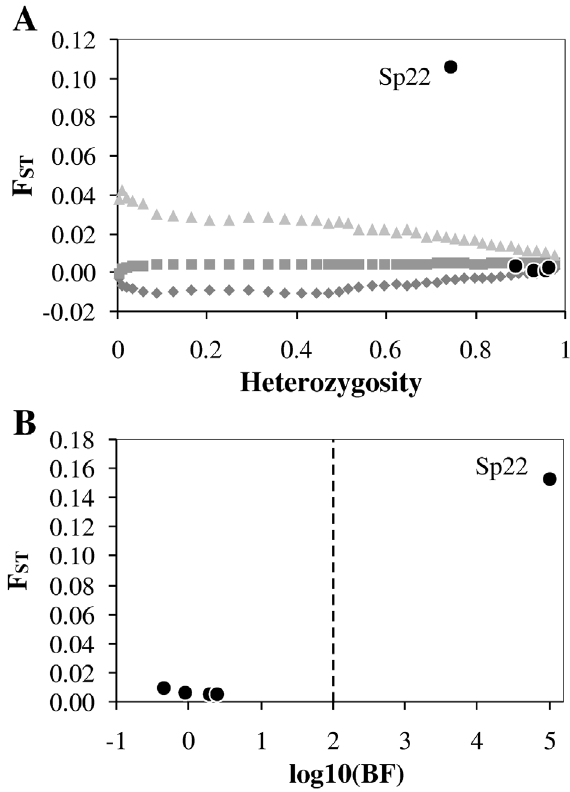
Fig . 3 – A, simulation results from the FDIST2 program. Upper and lower lines are the 95% confidence intervals and the middle line is the median. The estimated F and heterozygosity values for ST each locus (black circles) have been superimposed on the graph. B, results of the BAYESCAN approach. F values for each locus ST are plotted against their log-transformed Bayes factor. Broken line marks Log10(BF) of 2, which corresponds to posterior probability of